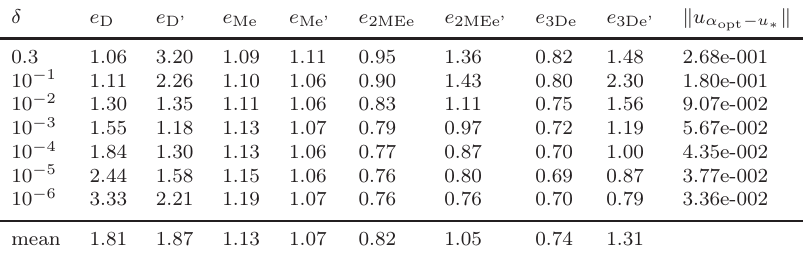
Table 9. Means of error ratios for u